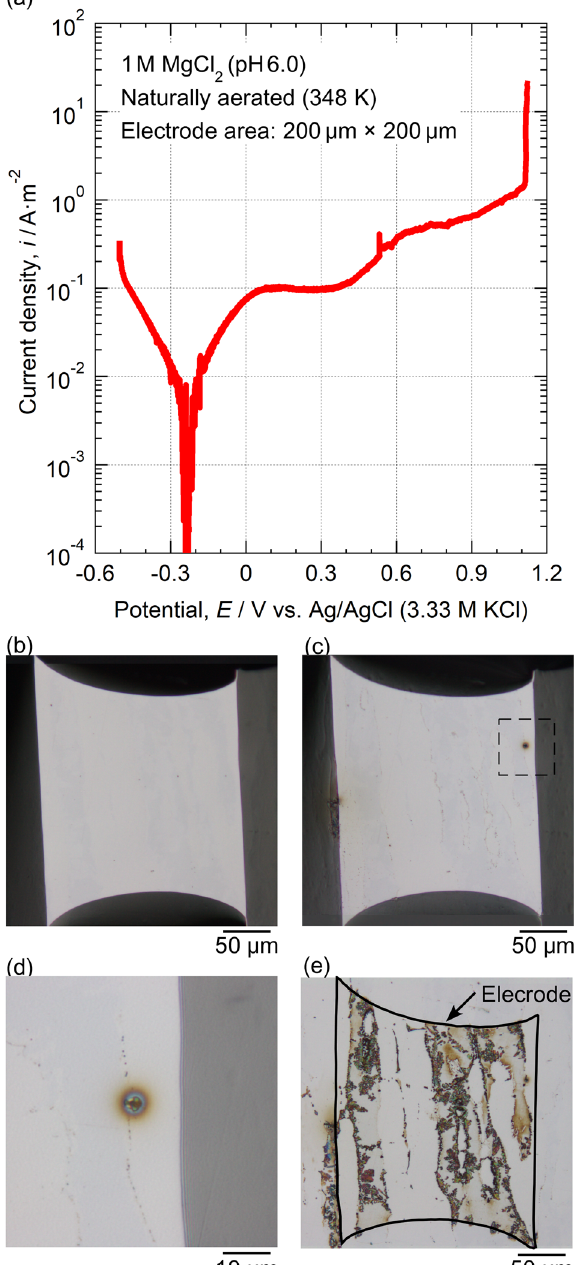
Fig. 8 Polarization behavior of a small electrode. a Polarization curve of a small area (200 × 200 μ m) of the aged specimen without inclusions in naturally aerated 1 M MgCl 2 at pH 6.0 (348 K). b , c Optical micrographs of the electrode area b before and c after polarization. d Enlarged view of the area demarcated by the dashed broken square in c . e Optical micrograph of the electrode area shown in c